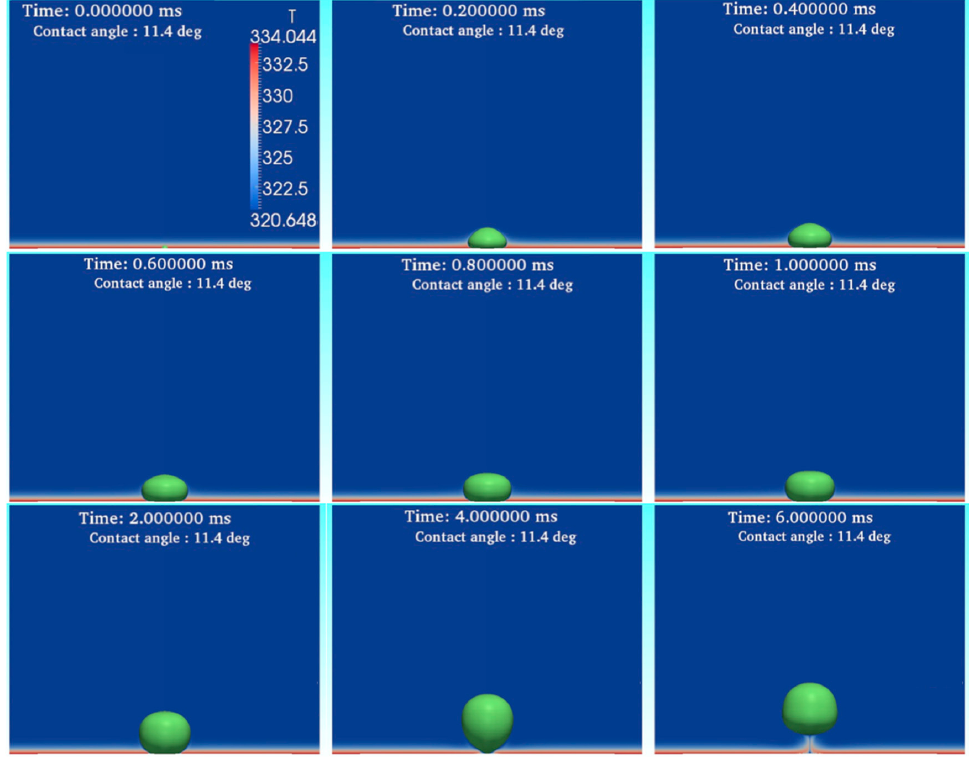
Figure 10. Three-dimensional bubble spatial and temporal evolution (base case, R113).